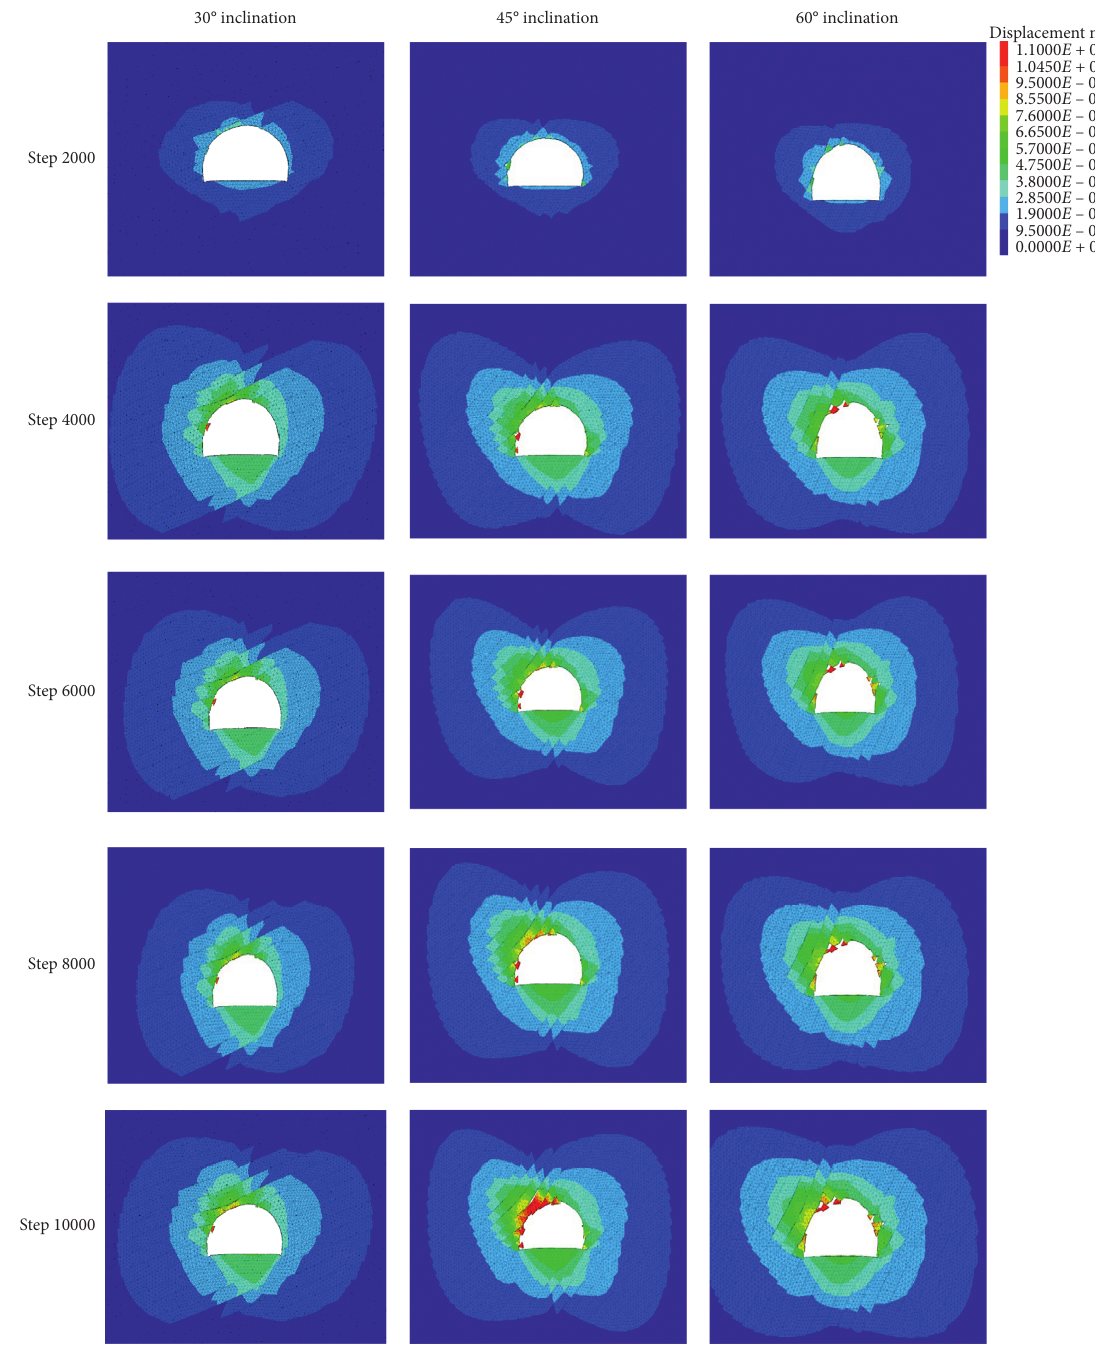
Figure 9: Distribution of surrounding rock displacement under different joint